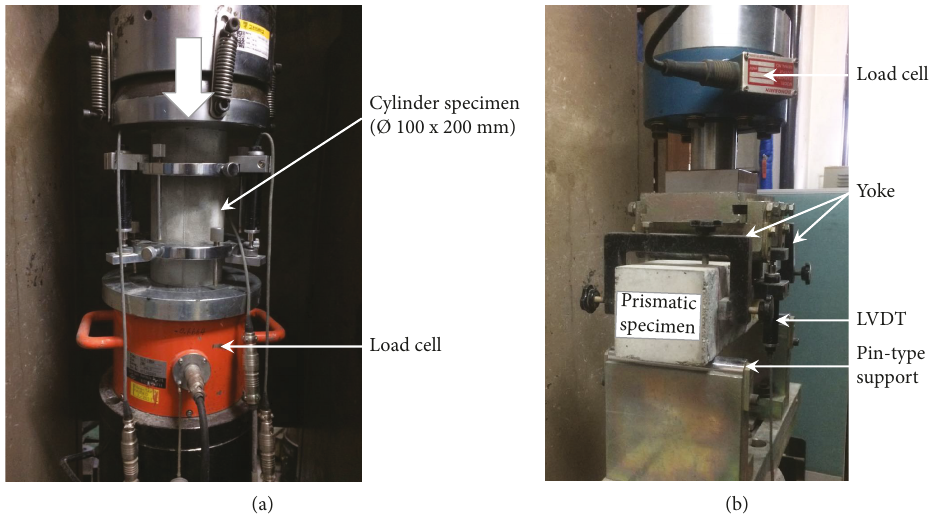
Figure 2: Mechanical test setup: (a) compressive test (ASTM C39) and (b) fl exural test (ASTM C1609). Table 5: Test results of compressive and fl exural